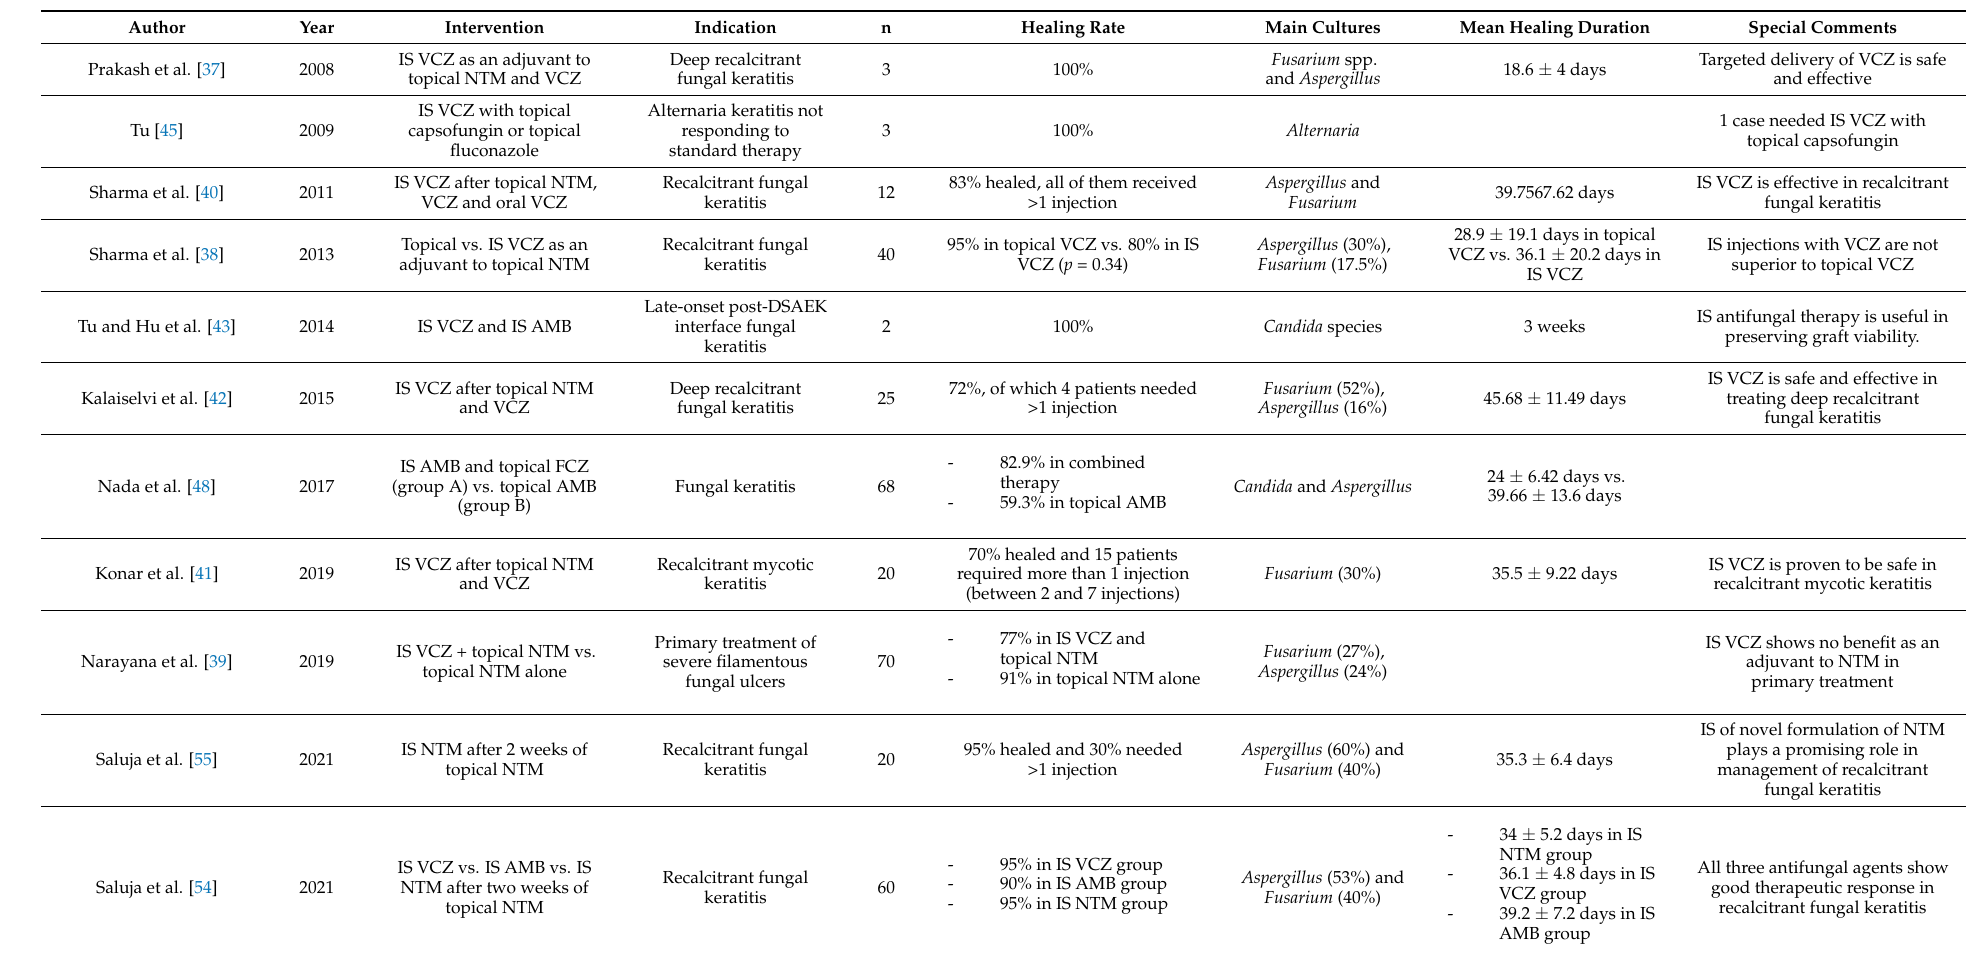
Table 1. Outcomes of intrastromal injections in the management of mycotic